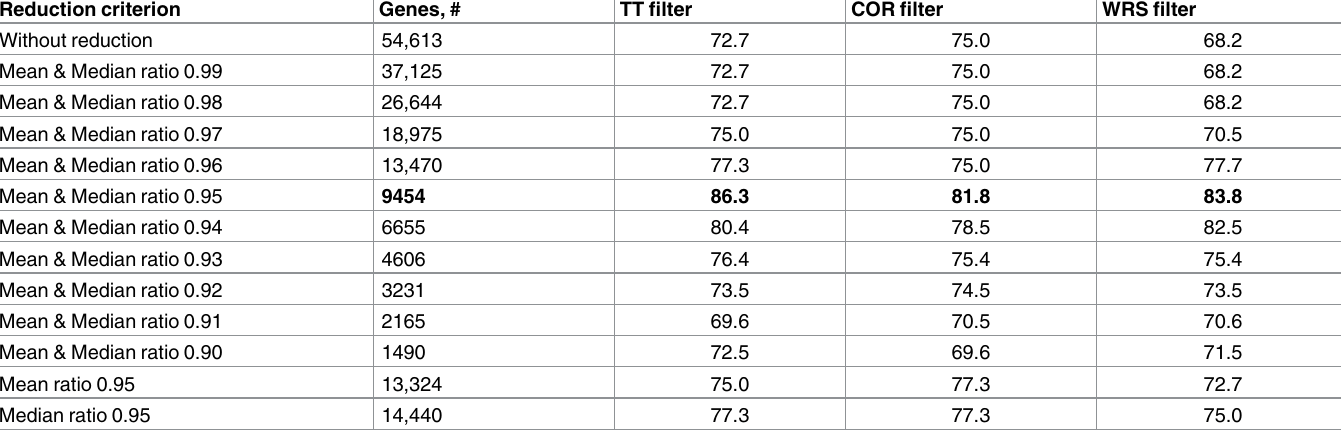
Table 4. Accuracypercentage of the SVM classifier at different stages of removal of similar genes and applied filtration results for 200 discrimina- tive genes. Reduction criterion